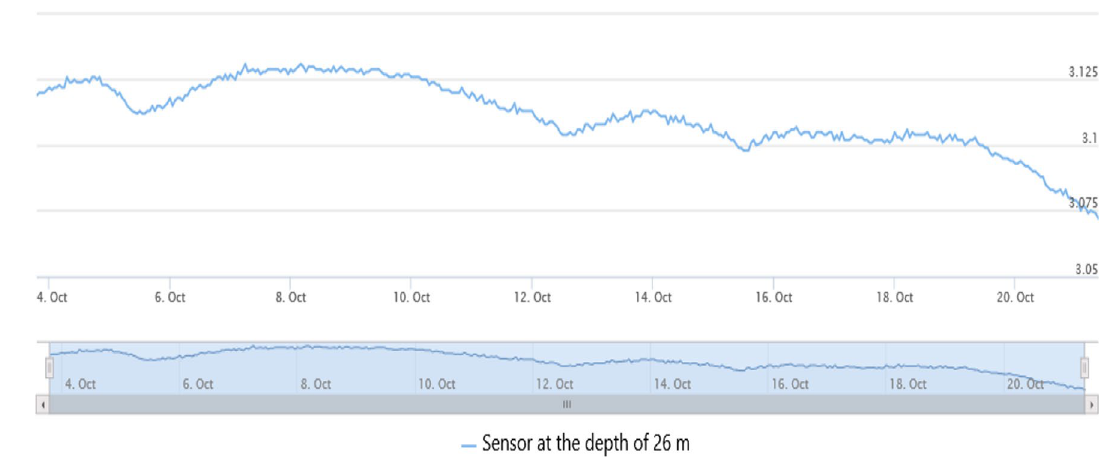
Fig. 8 Graphs of water pore pressure (own studies based on LoadSensing Data